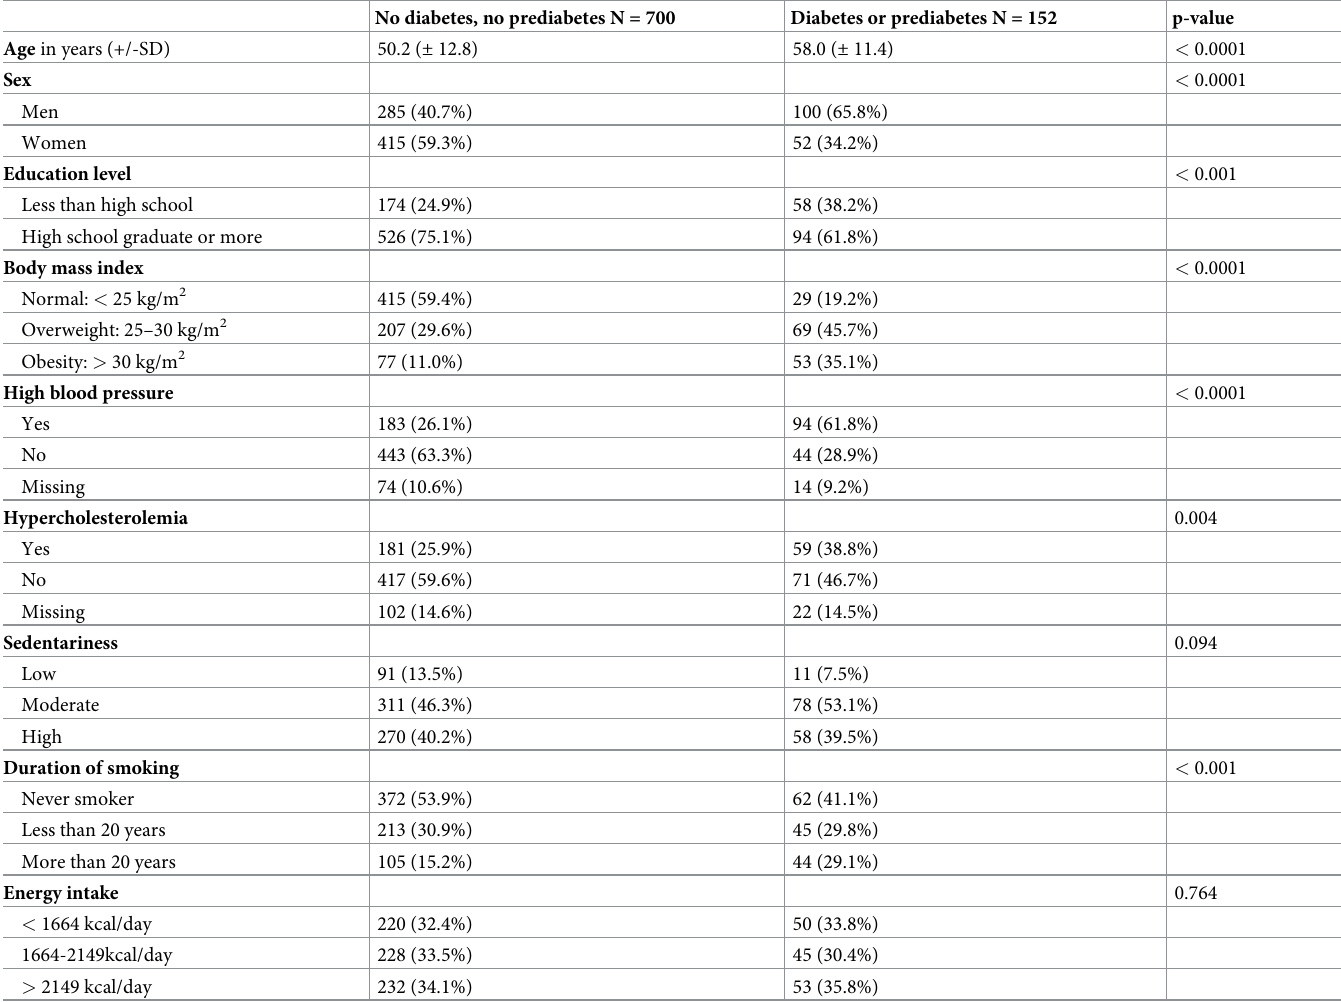
Table 1. Characteristics of participants according to diabetic or prediabetic status.